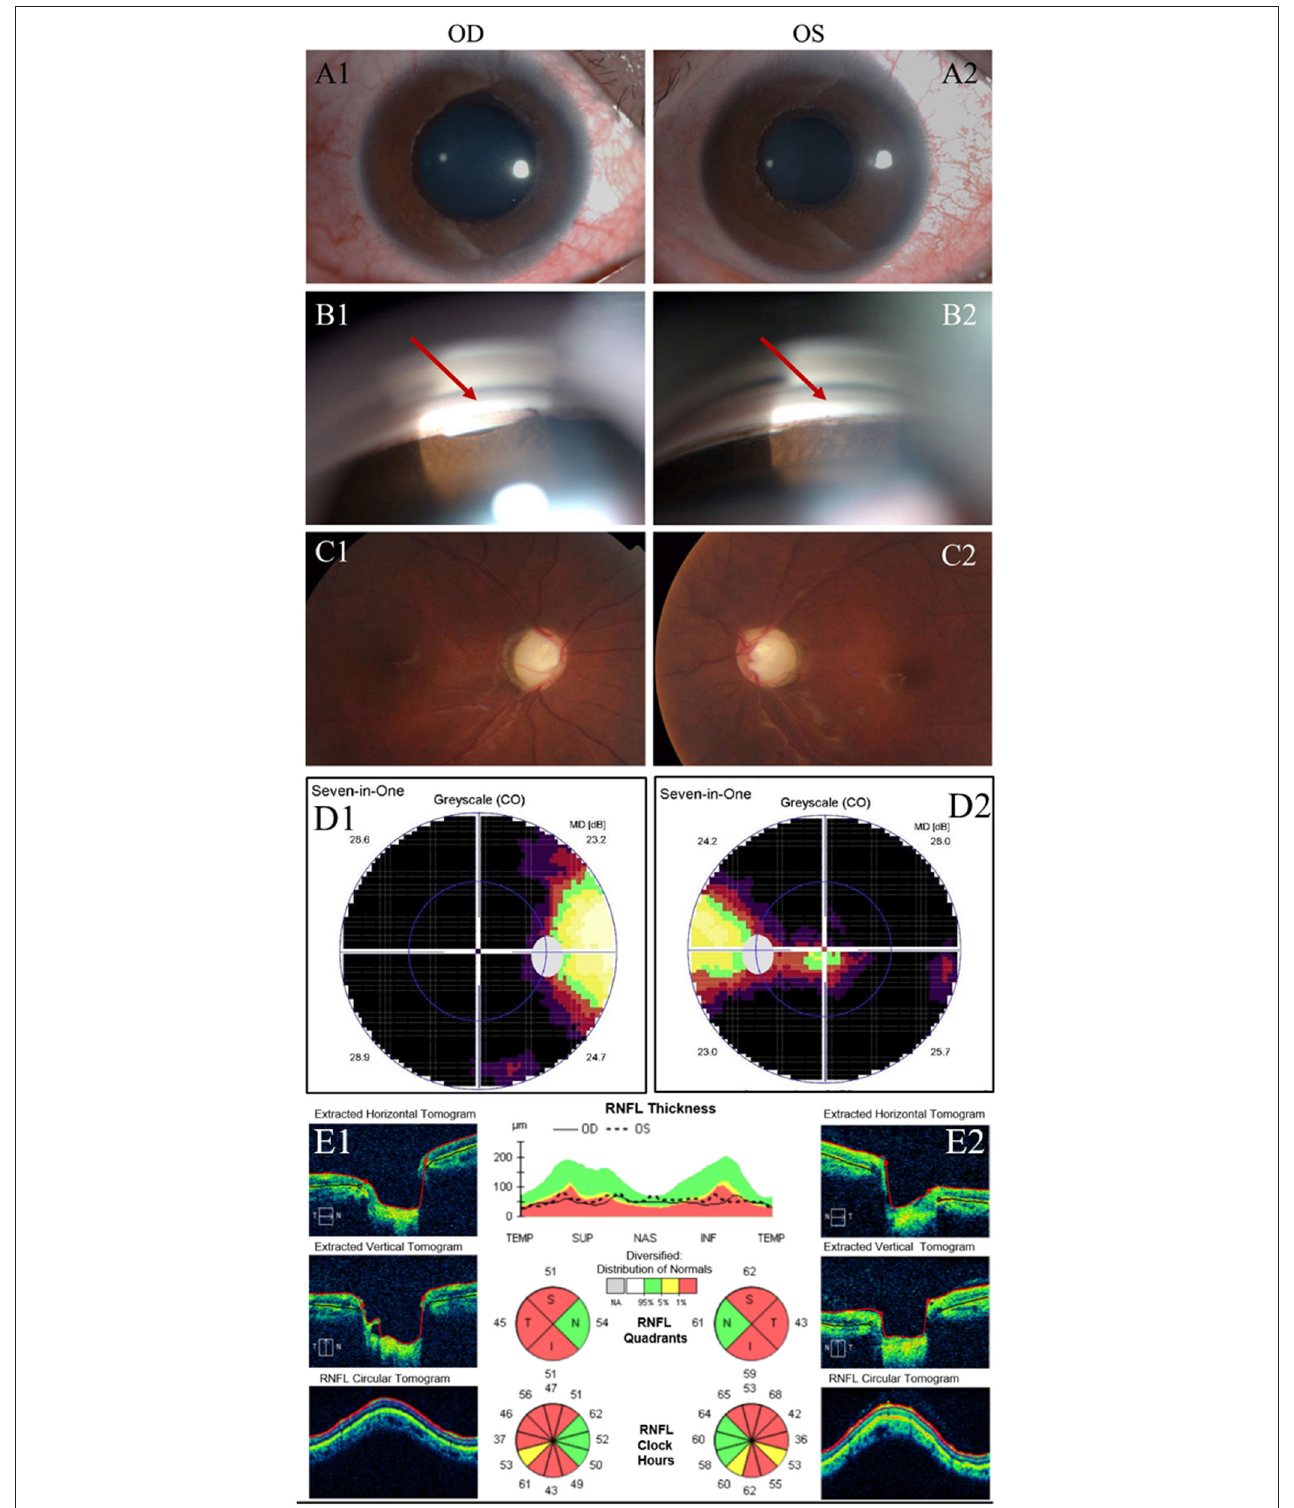
FIGURE 2 | Clinical presentation. (A) : Examinations of the patient before surgery. Slit-lamp examination showed 360-degree ectropion uveae in the right (A1) and left (A2) eyes. (B) : Gonioscopy showed anterior insertion of iris in the right (B1) and left (B2) eyes. (Red arrow) (C) : Fundus photos of the right (C1) and left eyes (C2) showed marked cupping, overpass phenomenon, notching of blood vessels, and thinning of neuroretinal rim at the upper and lower poles. (D) : Visual field testing showed temporal islands in right (D1) and left eyes (D2) . (E) : Retinal nerve fiber layer (RNFL) thickness in the right (E1) and left eye (E2) measured by OCT examination.